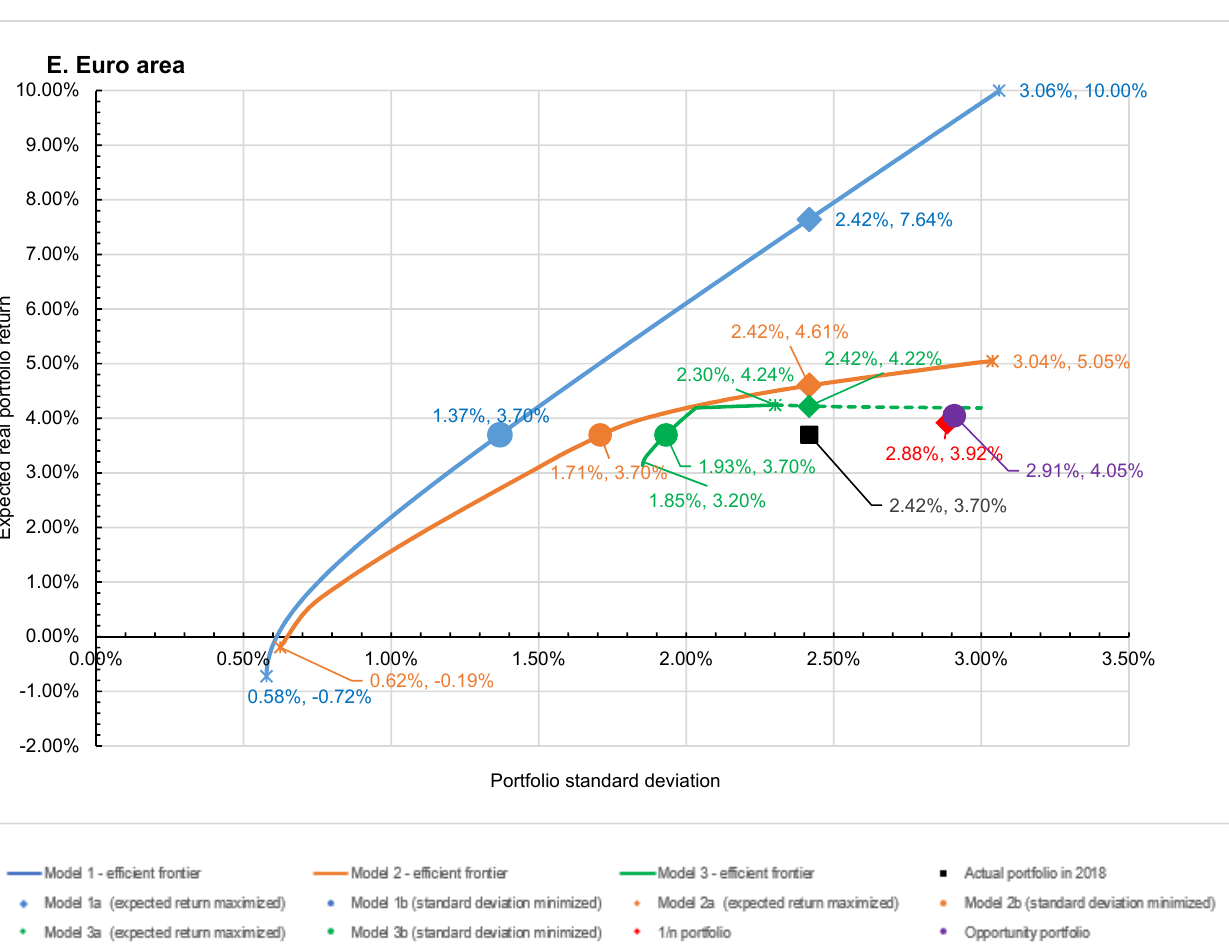
Figure 7. Efficient frontiers. Note: the numbers attached to the data points first indicate the standard deviations followed by expected real returns of the respective selected portfolios. Source: authors’ calculations. Table 3. Variance-covariance matrices and correlations.